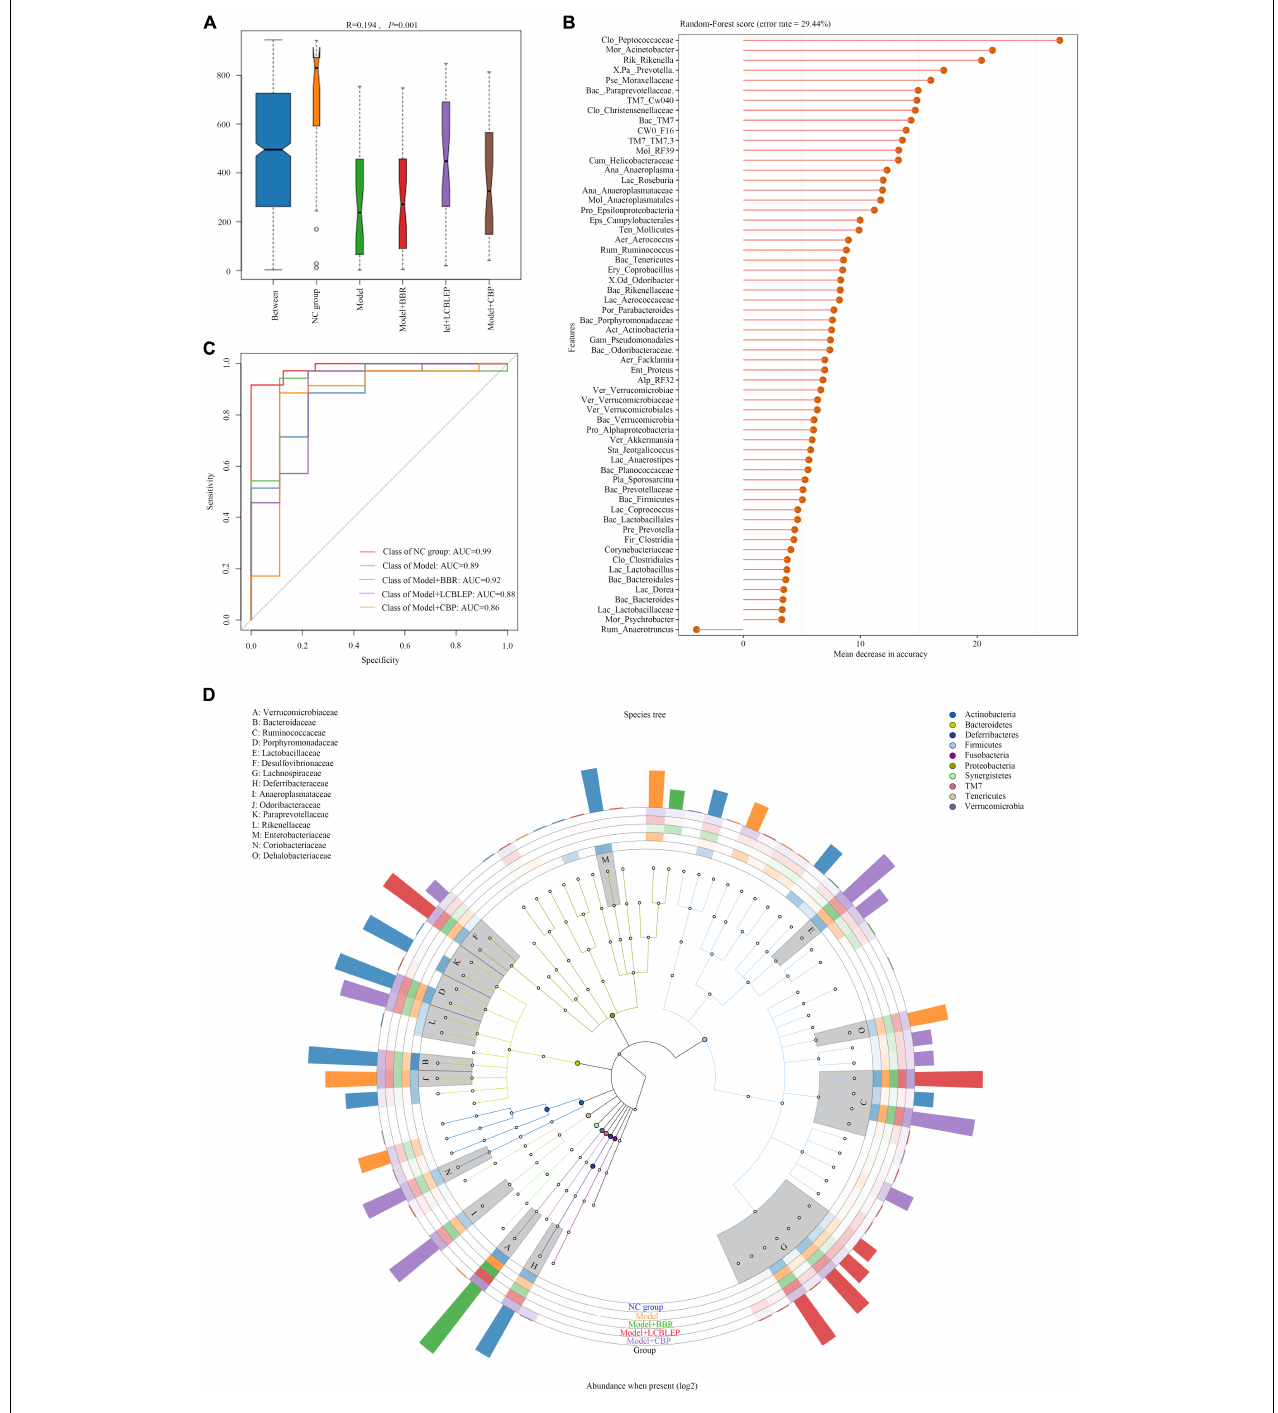
FIGURE 4 | (A) Species biomarkers were tested through analysis of similarities (ANOSIM) which was used to detect whether the difference between groups was significantly greater than the difference within groups, so as to judge whether the grouping was meaningful. R-value was used to compare whether there are differences between groups. If R-value was between ( − 1, 1) and greater than 0, the difference between groups was greater than that within groups. R-value < 0 indicated the inter-group difference was smaller than the intra-group difference. (B) Random forest classification tree with high accuracy was performed to effectively classify and predict the grouped samples. (C) The abscissa was the level of importance, and the ordinate was the species name in the order of importance. Receiver operating characteristic (ROC) curves were drawn at genus level. (D) GraPhlan figure, a map of sample communities in the evolutionary tree of species, was used to easily observe the dominant